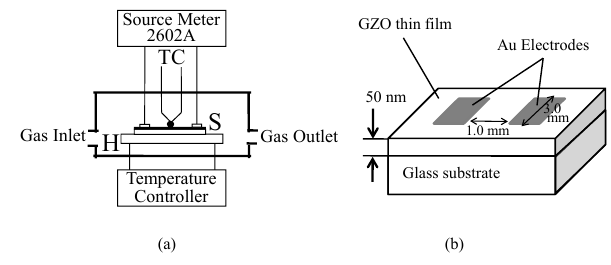
Figure 1. Schematic diagrams of (a) measurement set-up and (b) sample dimension. TC: thermocouple; H: heater; S: Ga-doped ZnO film on glass substrate.